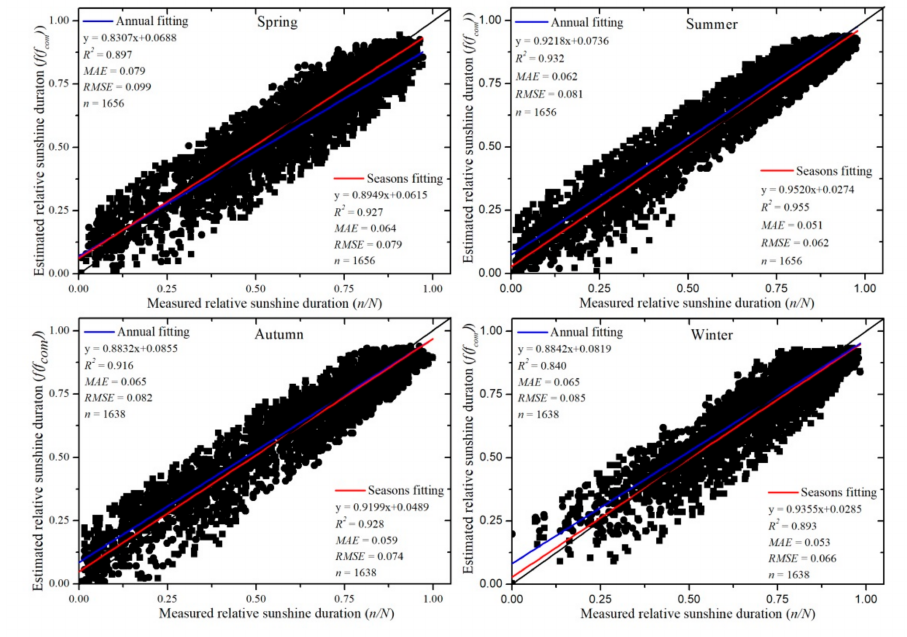
Figure 5. Comparisons of estimated daily relative sunshine duration by Equations (13) and (14), and measured daily relative sunshine duration at the 18 meteorological stations by season in